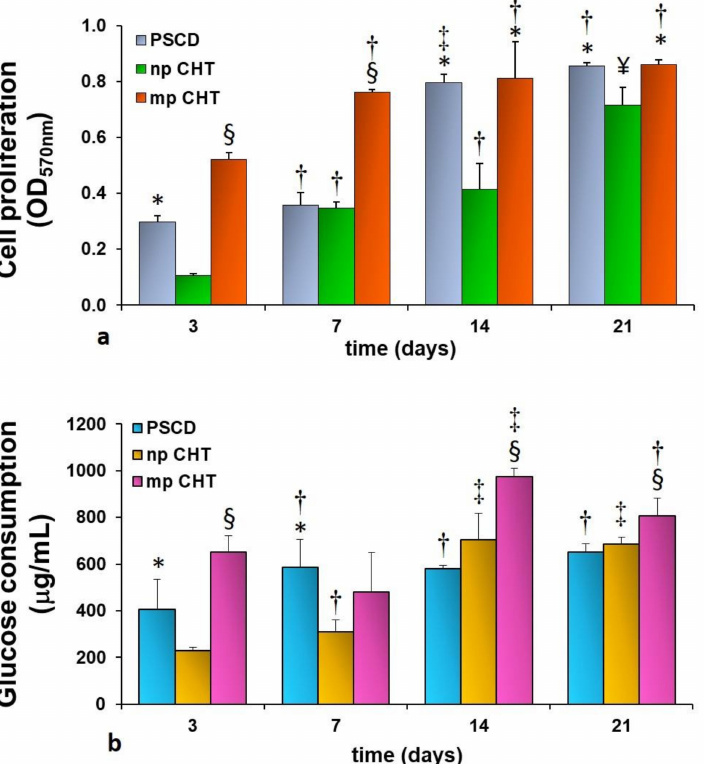
Figure 5. Cell proliferation ( a ) and glucose consumption ( b ) of human keratinocytes at different days of culture on nanoporous chitosan (np CHT) and microporous chitosan (mp CHT) membranes, and on polystyrene culture dishes (PSCD) as reference substratum. The values are the mean ± standard deviations of three experiments per configurations. Data are statistically significant according to ANOVA followed by Bonferroni’s t -test ( p < 0.05): (*) vs. np CHT, (§) vs. np CHT and PSCD, at the same day of culture; (†) vs. day 3, (‡) vs. days 3 and 7, (¥) vs. days 3, 7 and 14 of culture, on the same